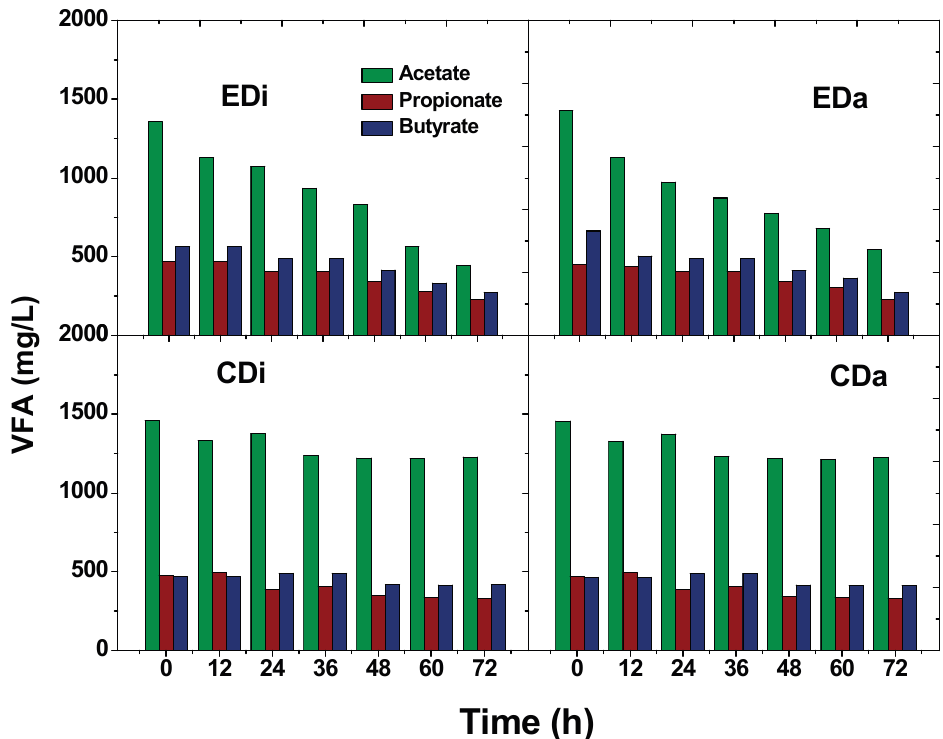
Figure 6. Compositional analysis of volatile fatty acids composition as a function of time with distillery and dairy wastewater in dark-fermentative system (DFS-CDi, CDa) and augmented dark-photo fermentative system (ADPFS-EDi,